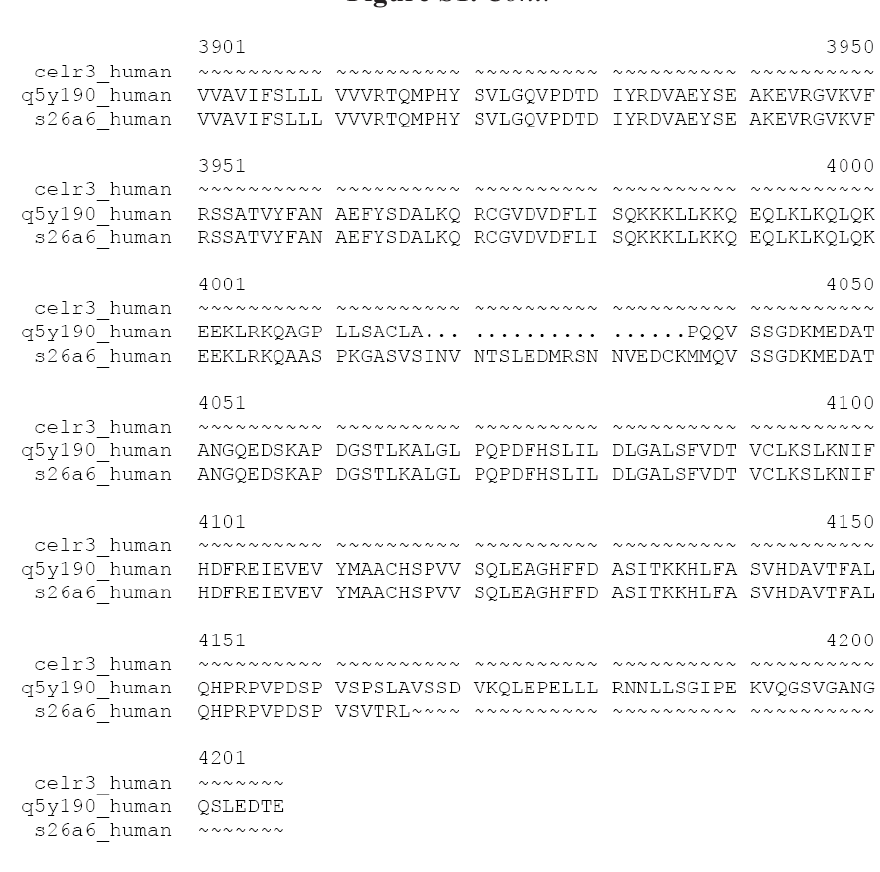
Figure S2. Alignment of MSRE_HUMAN, MSRE_RABIT, MSRE_BOVIN, MSRE_MOUSE with SCARA5_XENTR. Note that the predicted sequence SCARA5_XENTR is incomplete: the N-terminal region where macrophage scavenger receptor types I and II contain a PF03523 motif is missing from this incomplete